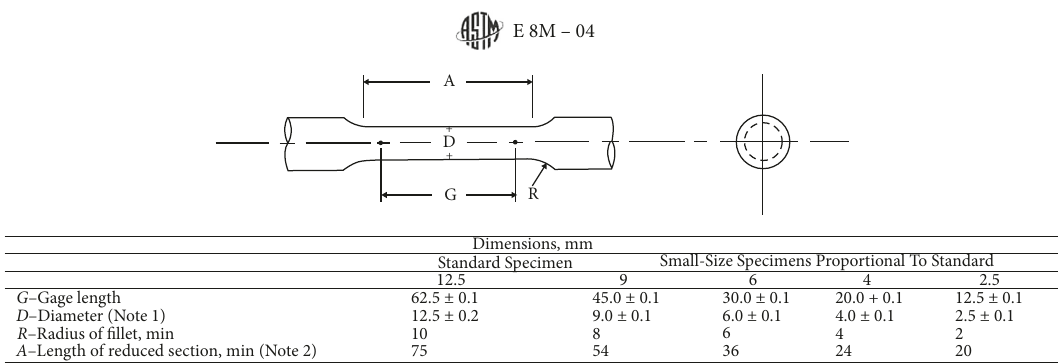
Figure 13: Tensile test specimen dimensions according to the standards.